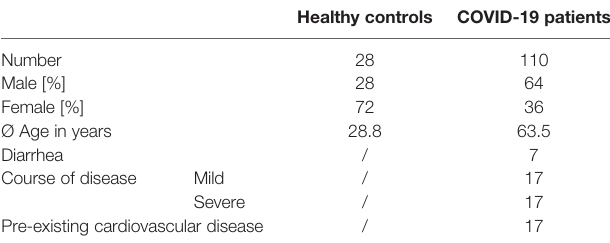
TABLE 1 | Baseline characteristics of patients with SARS-CoV-2 infection and healthy controls. Healthy controls COVID-19